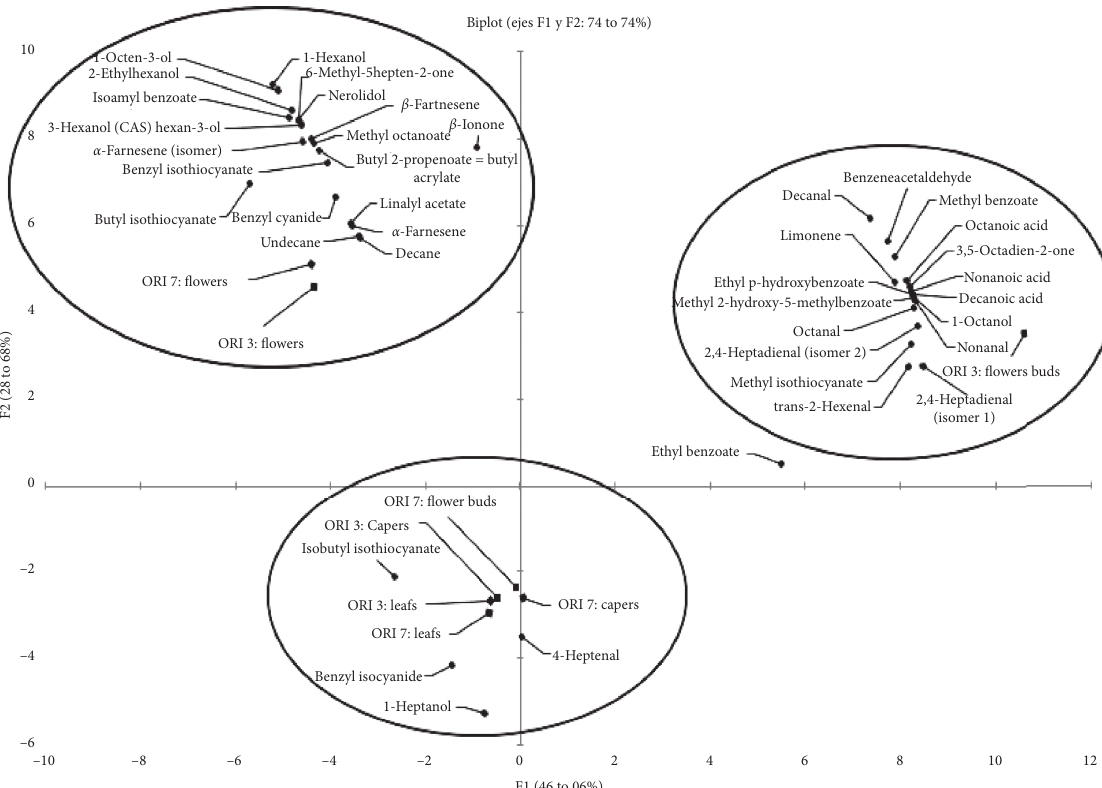
Figure 2: Principal component analysis (PCA) of different aerial parts of Capparis spinosa L. ( ) and volatile compounds (